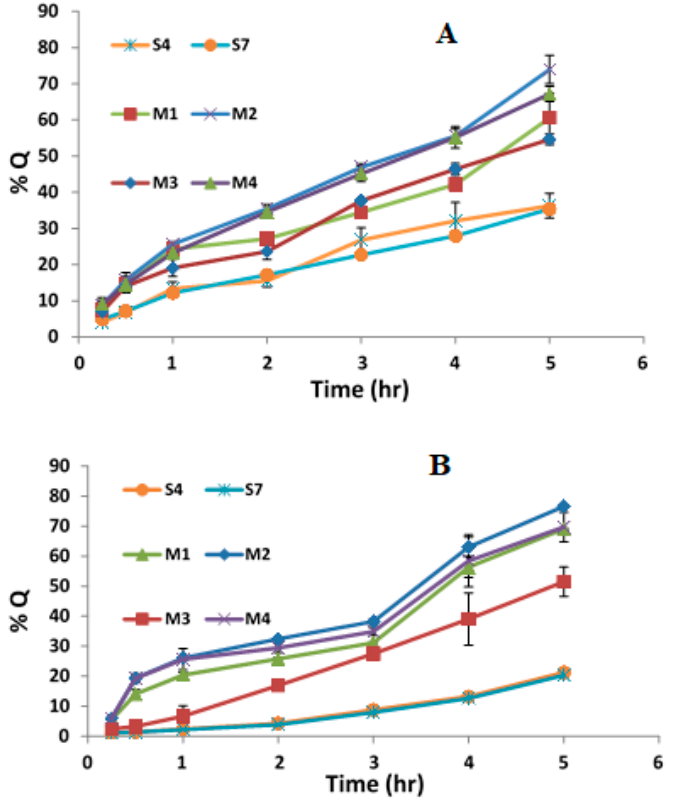
Figure 7. The permeation profile of ( A ) CAFF and ( B ) AA permeated across rat skin following the application of MNs and control (S4 and S7).